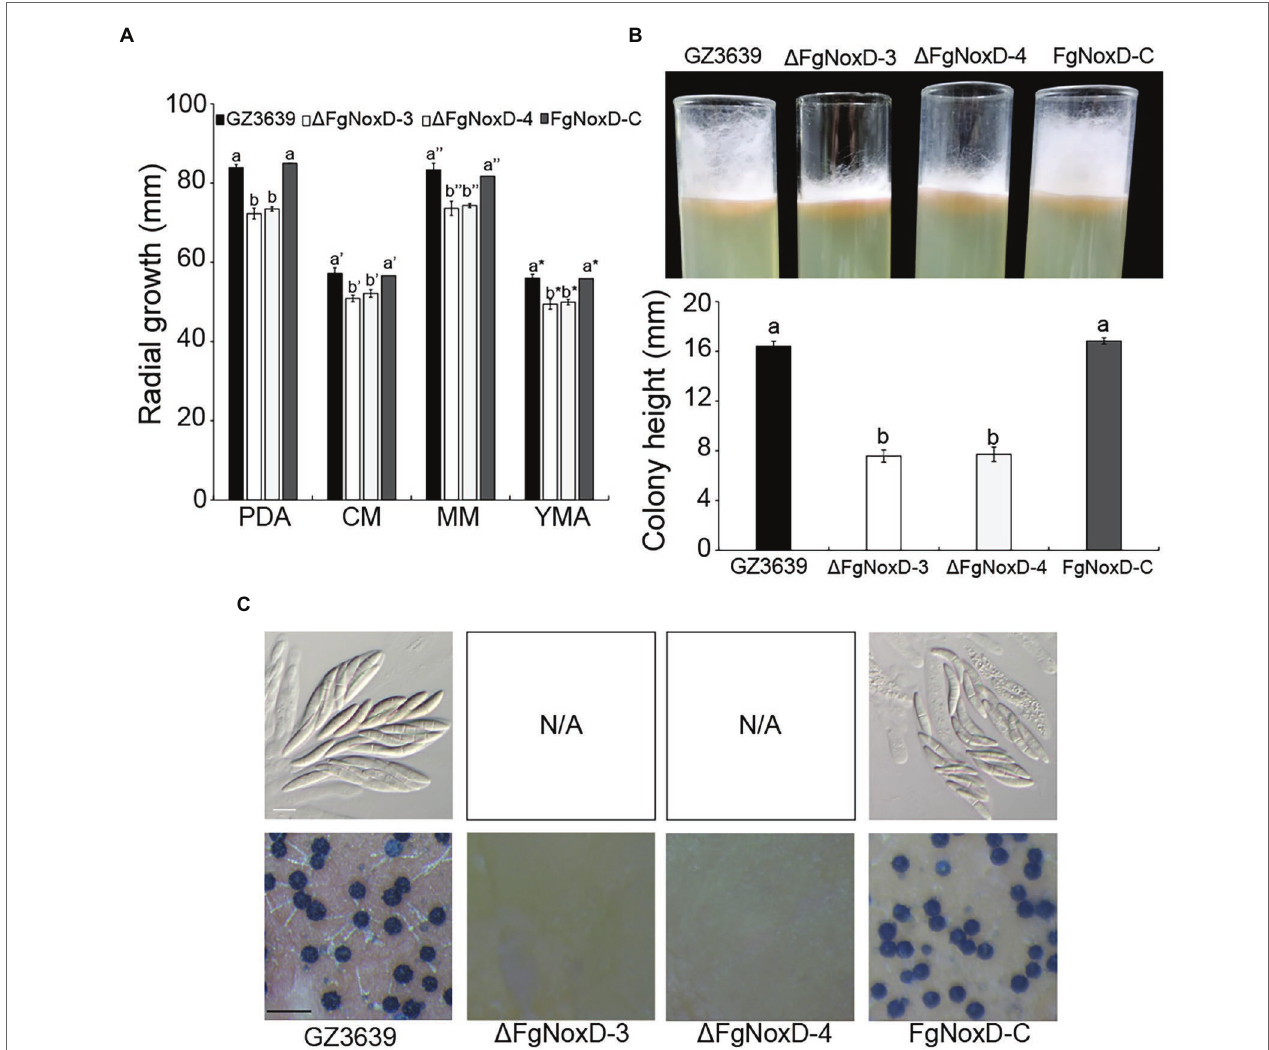
FIGURE 2 | Fungal growth and sexual development GZ3639, Δ FgNoxD, and FgNoxD-C. (A) The growth of GZ3639, Δ FgNoxD-3, Δ FgNoxD-4, and FgNoxD-C on potato dextrose agar (PDA), complete medium (CM), minimal medium (MM), yeast malt agar (YMA) for 3 days at 25 ° C. Colony diameters of the strains were measured. Error bars represent the SD from five replicates. (B) Aerial hyphae growth of the strains on CM for 3 days. Colony height of the strains was measured. Error bars represent the SD from three replicates. (C) Sexual development induced on carrot agar (CA) for 10 days at near UV. Perithecia formation and ascospores were observed after 10 days. White bar = 10 μ m; Black bar = 1 mm. Values with different letters are significantly different according to Tukey’s test ( p <